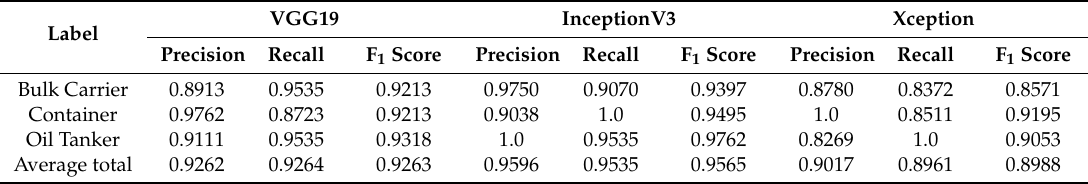
Table 10. Precision, recall, and F 1 score of the models based on VGG19, InceptionV3, and Xception.